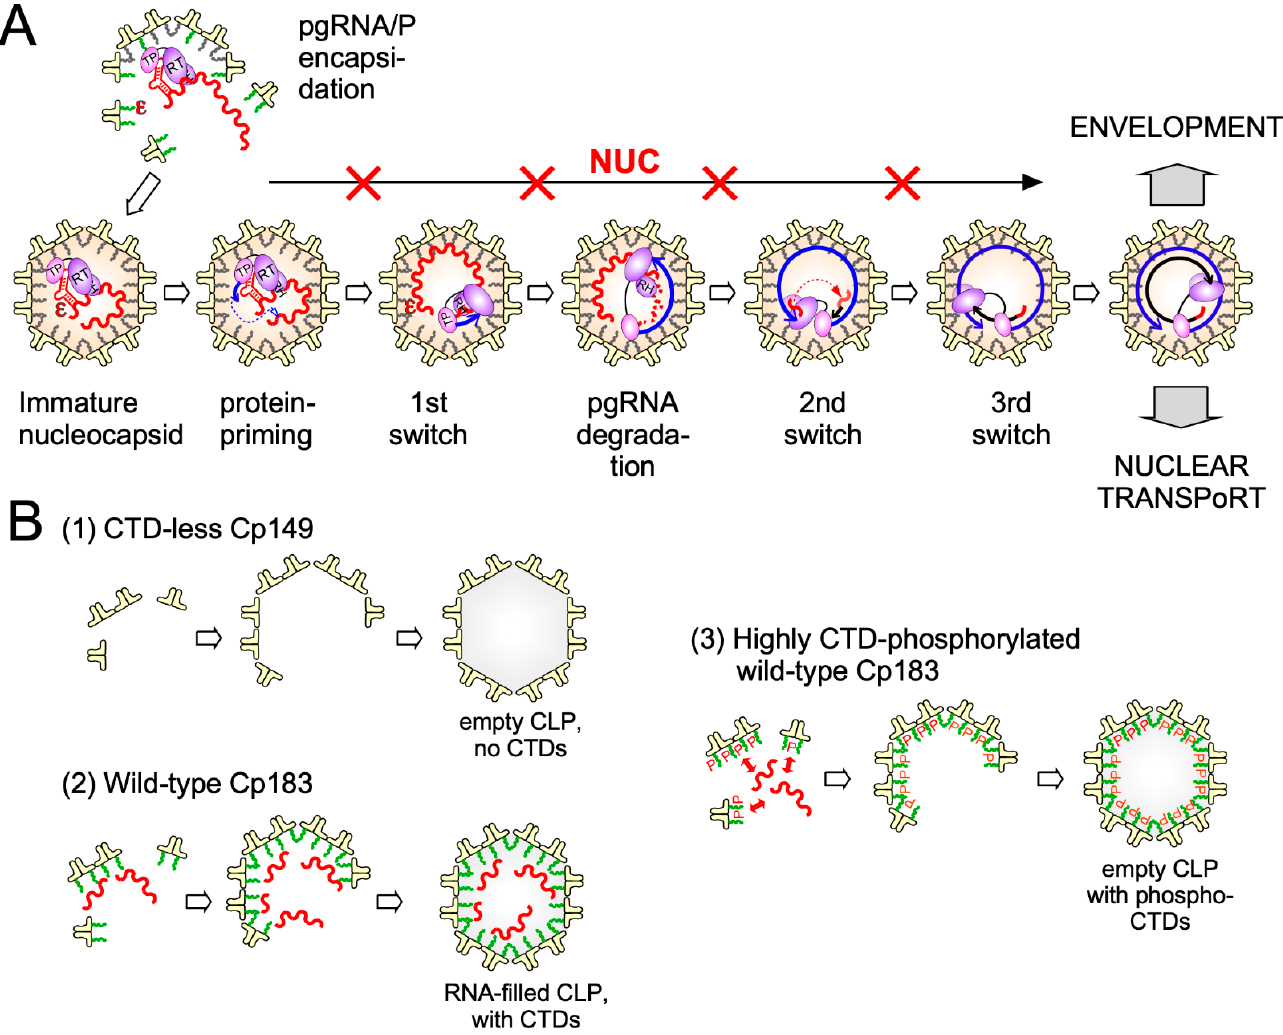
Figure 3. ( A ) The HBV capsid as distinct replication compartment. The pgRNA-P protein complex recruits Cp subunits, initiating assembly of nucleocapsids wherein pgRNA is reverse transcribed into rcDNA. P binding to ε also mediates protein-primed initiation of DNA synthesis at the ε bulge, covalently linking the TP domain to the DNA 5 ′ end. The short DNA oligo is transferred close to the pgRNA 3 ′ end (first switch) and extended towards the 5 ′ end, with degradation of the RNA in the nascent DNA-RNA hybrid. A 5 ′ terminal RNA oligo remains, is transferred to an acceptor not far from the 5 ′ end of the new minus-strand DNA (second switch), and primes plus-strand DNA synthesis. When reaching the tem- plate’s 5 ′ end a third switch to the 3 ′ end enables circularization and further extension into mature rcDNA. NUCs inhibit DNA synthesis but not immature nucleocapsid formation. Genome maturation is assumed to induce a structural change on the capsid that signals readiness for envelopment, and also for nuclear transport as part of the recycling pathway; in neither case is the new viral DNA exposed in the cytoplasm, minimizing immune recognition as non-self. Conceivably, the entire genome maturation process is accompanied by as yet unidentified conformational alterations in the capsid. RNA is shown as red wavy line, minus-strand DNA in blue, plus-strand DNA in black. Small amounts of ds linear (dsL) DNA from a failed second template switch are not indicated. ( B ) Nonproductive assembly paths of recombinant Cps expressed in E. coli . In the absence of the basic C terminal domain (CTD), Cps comprising an intact N-terminal assembly domain